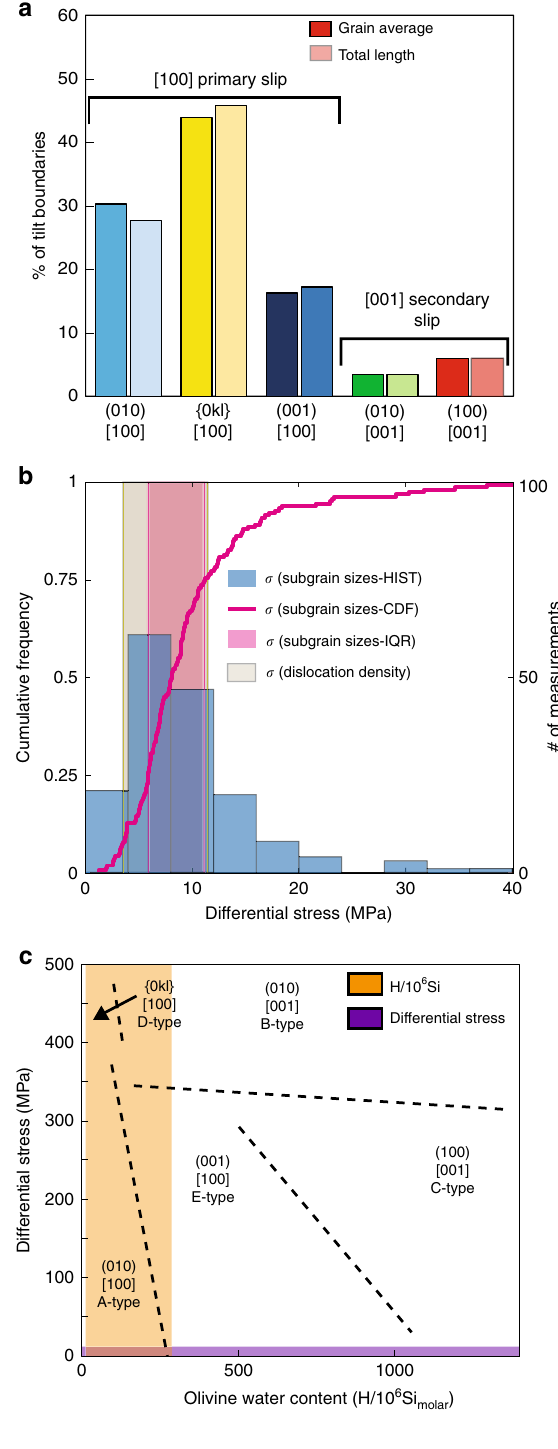
Fig. 8 Quantifying the conditions of deformation. a Proportions of each slip system calculated by averaging the proportion of each slip system per grain (darker colors; giving equal weight to all grains regardless of their size), and by summing the total length of each boundary type in 62 deformed grains (lighter colors). All deformed grains contain [100] weighted Burgers vector directions (WBVDs), suggesting that this is the primary slip direction. Only a subset of grains contain low angle boundaries with [001] WBVDs, suggesting that this is a secondary slip direction. b Differential stresses calculated using subgrain piezometery (see ref. 52 ) applied to linear intercept distances clearly overlap with those estimated from dislocation density piezometery (see ref. 42 ) on published dislocation densities (see ref. 29 ). Differential stress estimates are shown as a cumulative density function (CDF-magenta) with the interquartile range (IQR-light pink), and as a histogram (HIST-darker blue). c Olivine regime diagram (see ref. 56 ) for T = 1470 – 1570 K with subgrain stress estimates (purple bar) and olivine water contents (orange bar)